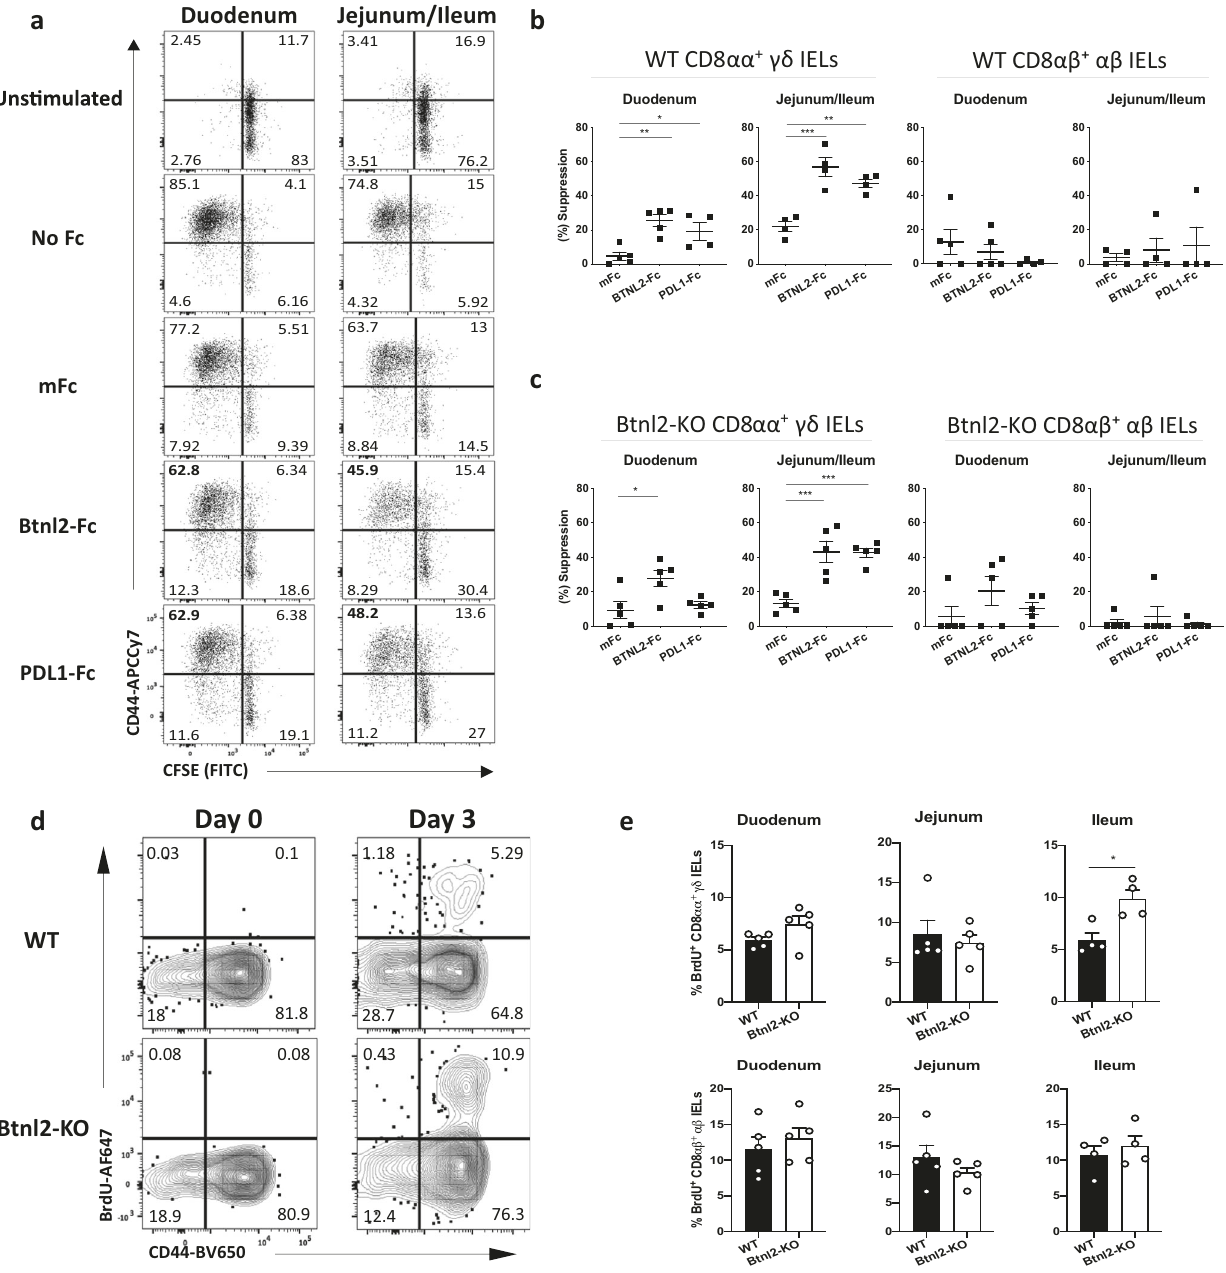
Fig. 3 Btnl2 suppresses proliferation of jejunal/ileal γδ IELs. IELs were isolated from duodenum and jejunum/ileum of cohoused 12-week-old Btnl2-KO and WT mice ( n = 4 – 5, each), labeled with CFSE and stimulated with α -CD3 and different Fc fusions in the presence of rh IL-2, rmIL7, rm IL15 for 84 h. Supernatants from the cell cultures were collected and cells were processed for fl ow cytometry. a Representative fl ow cytometry plots of duodenal and jejunal/ileal WT CD8 αα + γδ IELs following 84 h of culture in the presence of equimolar concentrations of Btnl2-Fc and control mFc fusion proteins. b , c Suppression of proliferation calculated as the percent difference between the proliferation in the presence of a speci fi c Fc fusion and no Fc fusion, relative to the proliferation in the absence of Fc fusion. b Suppression of proliferation of duodenal and jejunal/ileal WT CD8 αα + γδ IELs and CD8 αβ + αβ IELs. c Suppression of proliferation of duodenal and jejunal/ileal Btnl2-KO CD8 αα + γδ IELs and CD8 αβ + αβ IELs. Error bars represent mean ± SEM. Signi fi cance is measured using one-way ANOVA, * p < 0.05, ** p < 0.005, *** p < 0.001, **** p < 0.0001, signi fi cantly different from mFc fusion protein control. d , e Cohoused 11-week-old Btnl2-KO and WT mice ( n = 4 – 5, each) were given BrdU at 0.8 mg/mL ad libitum in drinking water for 3 days. BrdU incorporation was measured by intranuclear staining of γδ IELs from different segments of the small intestine over time. d Representative fl ow cytometry plots of BrdU incorporation in ileal CD8 αα + γδ IELs. e BrdU incorporation in CD8 αα + γδ IELs and CD8 αβ + αβ IELs across different segments. Error bars represent mean ± SEM. Signi fi cance is measured using unpaired t -tests assuming similar SD, * p < 0.05, ** p < 0.005, *** p < 0.0005, **** p < 0.0001, signi fi cantly different from